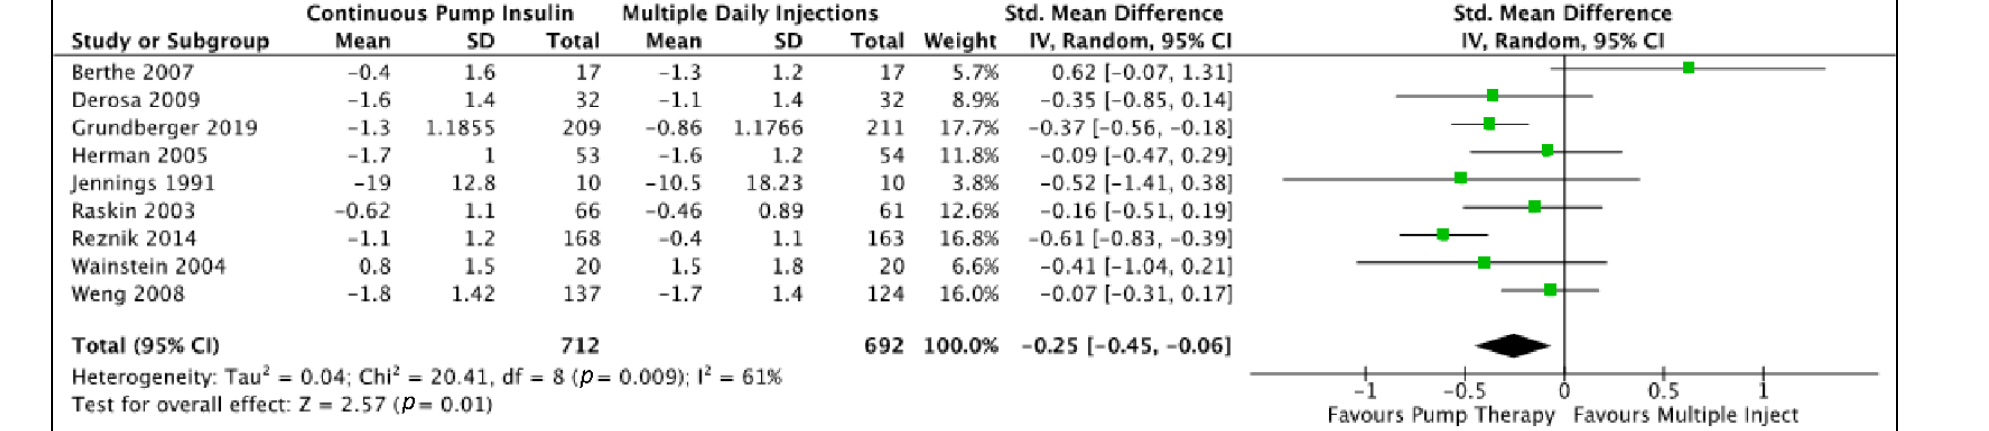
Figure 4. Meta-analysis results and Forest plot for Glycated HbA1c. Table 4. Pooled results of meta-analysis and sensitivity analysis for each outcome.